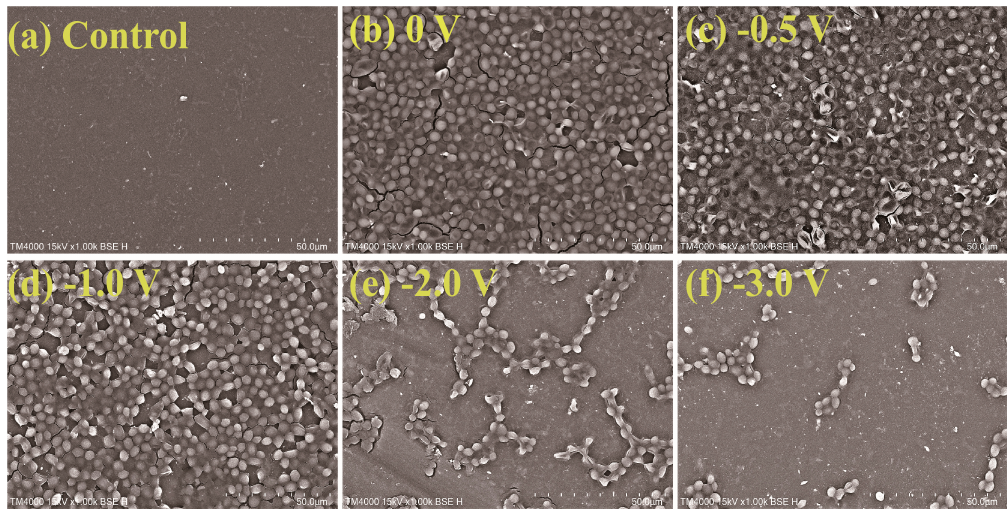
Figure 8. Adhesion of yeast cells on membrane surfaces under different voltage conditions after 1 h of filtration: ( a ) control, ( b ) 0 V, ( c ) − 0.5 V, ( d ) − 1.0 V, ( e ) − 2.0 V and ( f ) − 3.0 V.